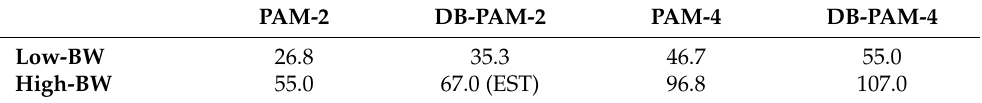
Table 2. Maximum bit rate [Gb/s] achieved by each format for BER ≤ 10 − 2 in BtB